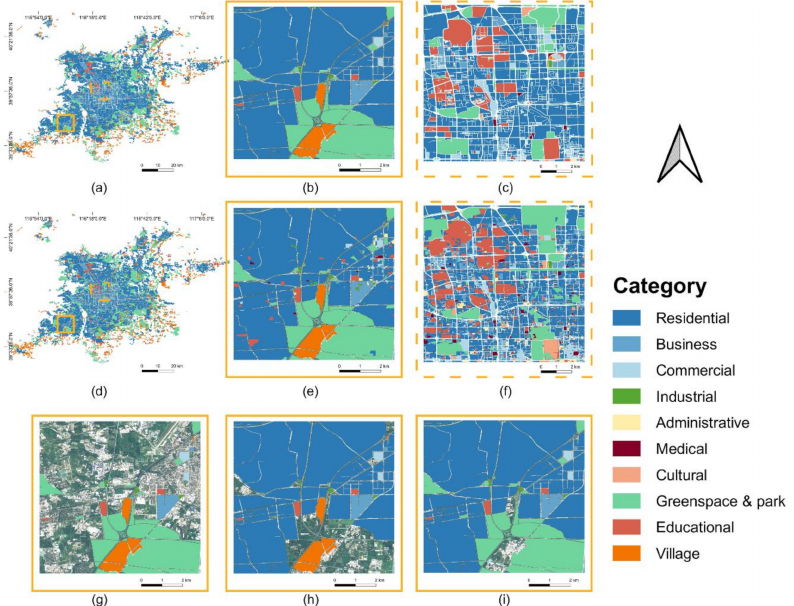
Figure 16. Comparison and zoomed-in views of EULUC-AOI (OSM) in Beijing, 2019. ( a ) The mapping results before overlaying the AOIs layers; ( b , c ) zoomed-in views of ( a ); ( d ) the mapping results after overlaying the AOIs layers; ( e , f ) zoomed-in views of ( d ); the zoomed-in views with solid lines outside shows details in the solid box in the lower-left corner of the mapping results. The zoomed-in view with dashed lines outside shows details in the dashed box near the middle of the mapping results. ( g – i ) The results of ( b ) with the removal of residential, greenspace, and village units in turn, with Sentinel II optical images in the